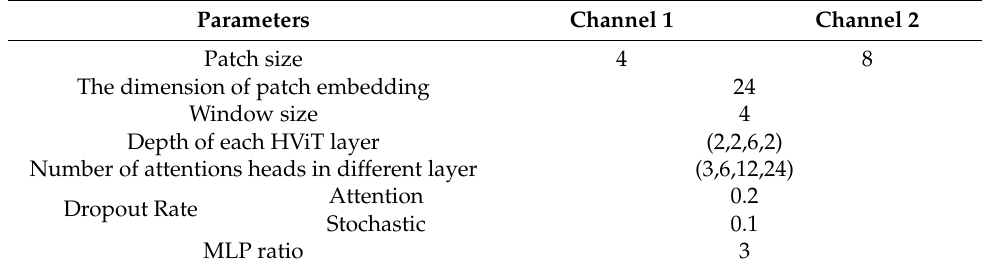
Table 4. Parameters of feature extraction network.